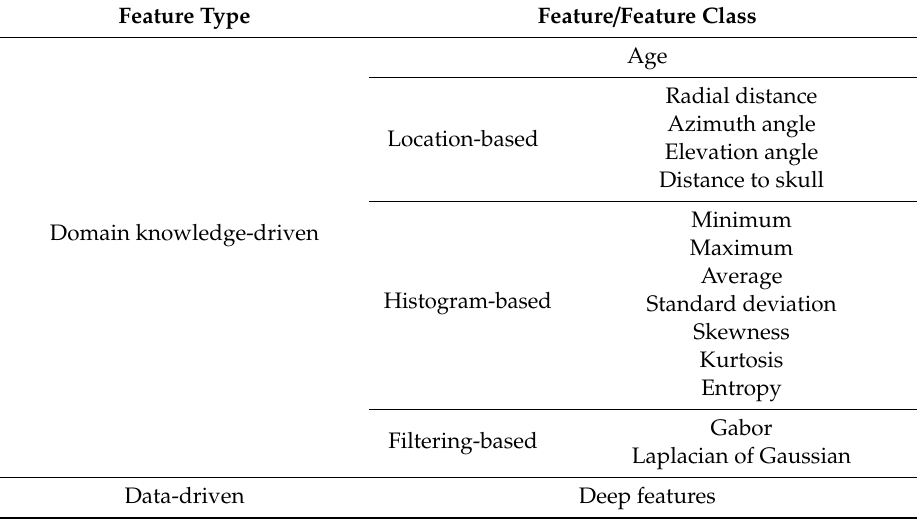
Table A1. The comprehensive list of the utilized hand-crafted and deep